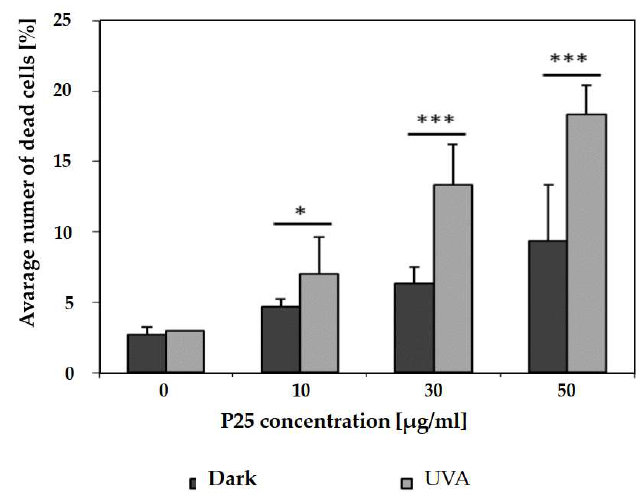
Figure 3. The effect of P25 NPs on MCF7 cells after 10 min of treatment in dark conditions and under UVA / vis light irradiation: *— p ≤ 0.05; **— p ≤ 0.01; ***— p ≤ 0.001 (Wilcoxon test).